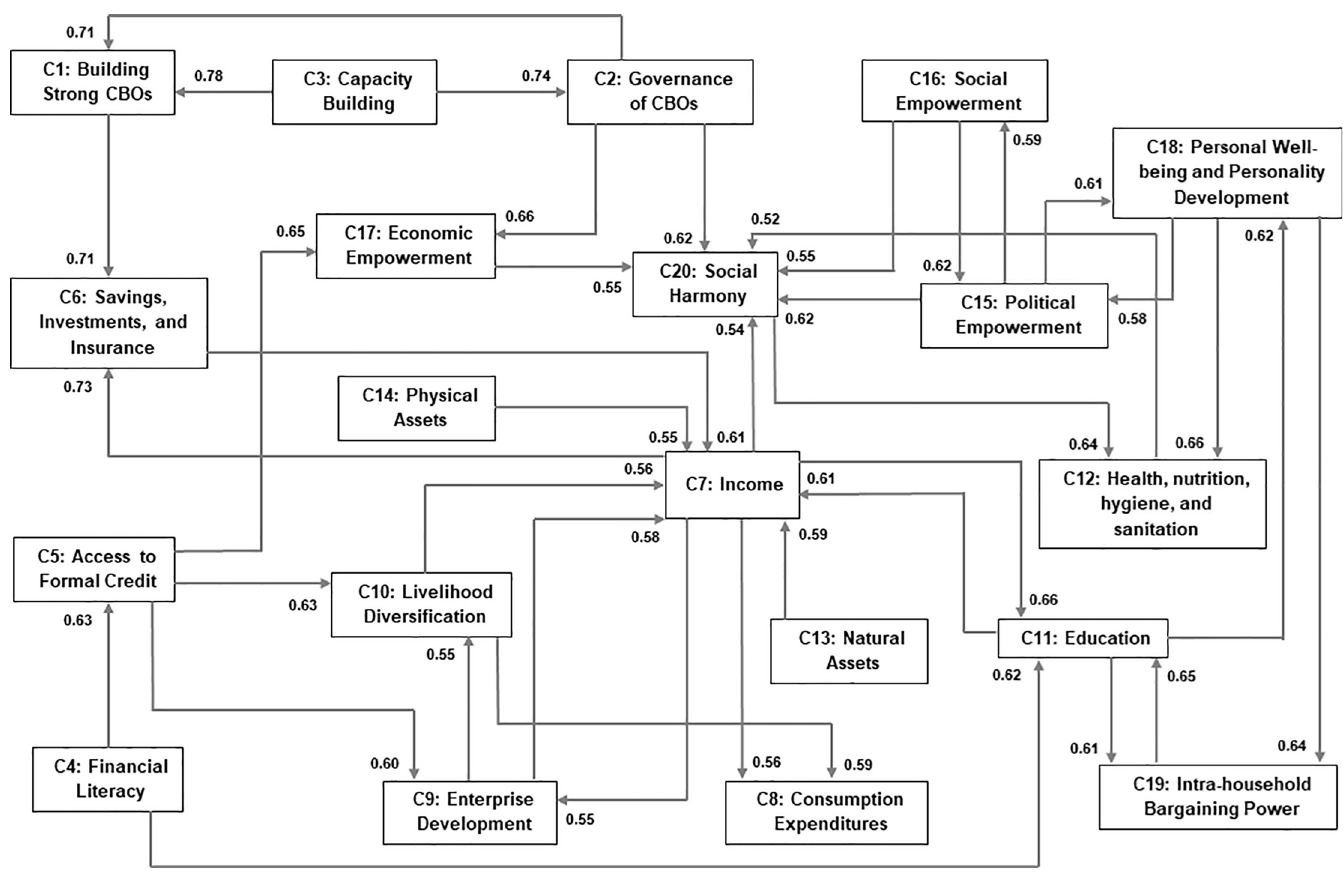
Fig 3. Expert-based FCM